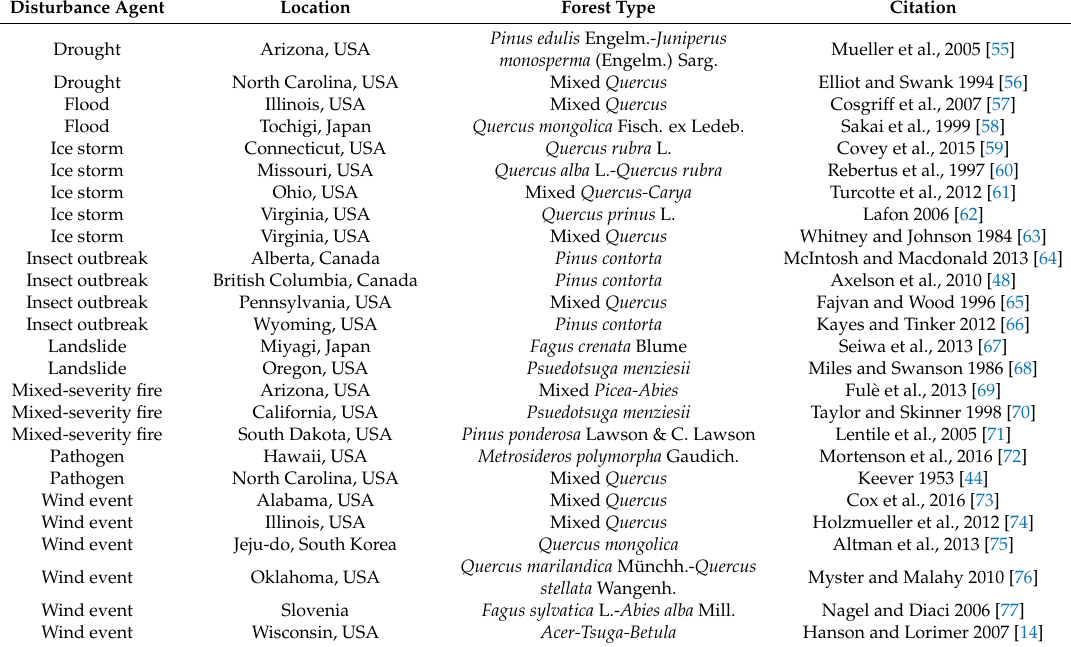
Table 1. Examples of studies that have investigated intermediate-severity forest disturbances from a variety of disturbance